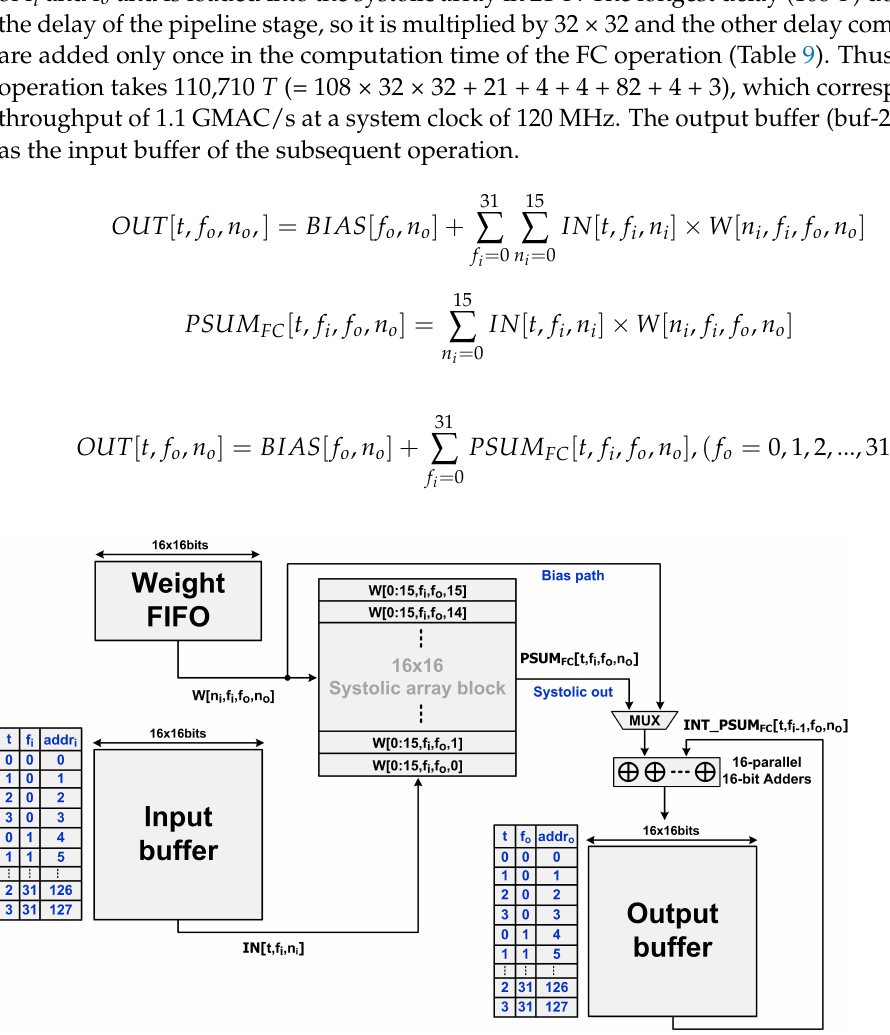
Figure 7. Hardware operation of FC example in Table